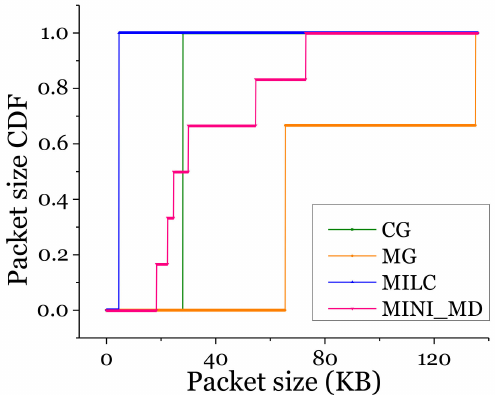
Figure 4. Cumulative distribution function (CDF) of the packets size of the 4